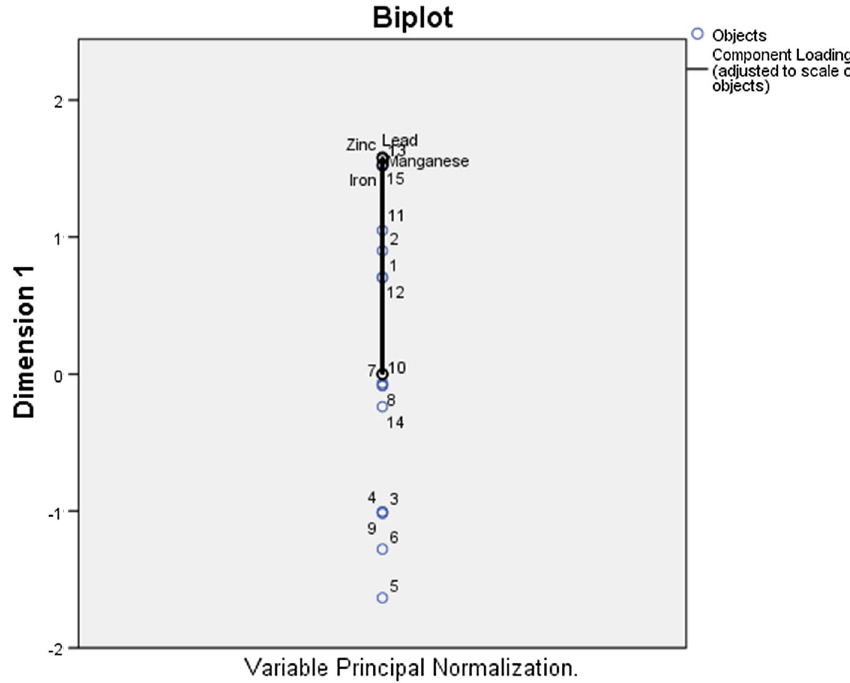
Fig. 4 Biplots of the